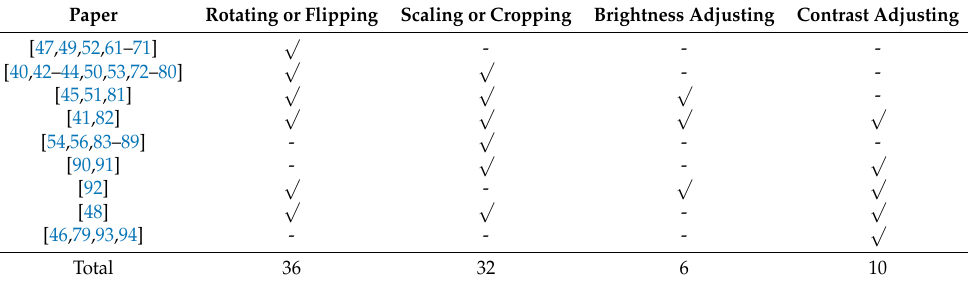
Table 3. Basic transformation-based data augmentation methods. The last row summarizes the total number of papers that adopt the corresponding approach.